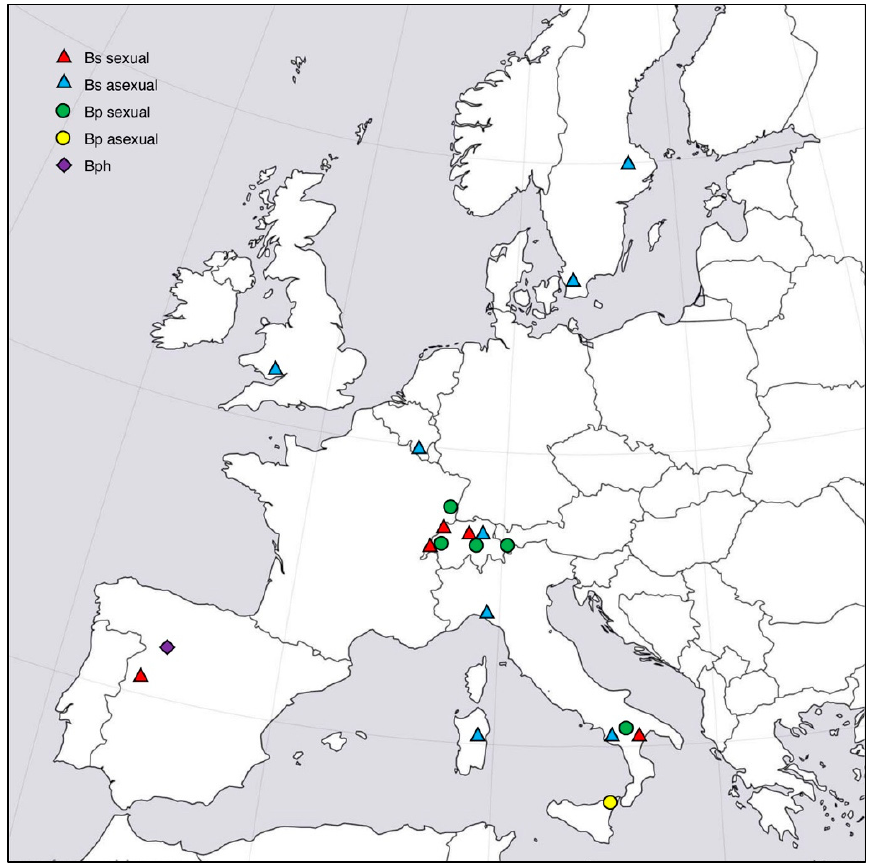
Figure 1. Location of collection sites in Europe of Epichloë -infected Brachypodium species: B. sylvaticum (Bs), B. pinnatum (Bp) and B. phoenicoides (Bph). Symbols distinguish between host, and stroma- forming (sexual) or symptomless (asexual) infections. Table 1. Epichloë isolates from Brachypodium and Calamagrostis hosts used in this study with mode of reproduction (sexual or asexual) and source of isolation (culm, culm with stroma, seed, stroma tissue or ascopores). In addition, use for microsatellite analysis (+) and GenBank accession numbers are indicated (new sequences of this study are in bold).